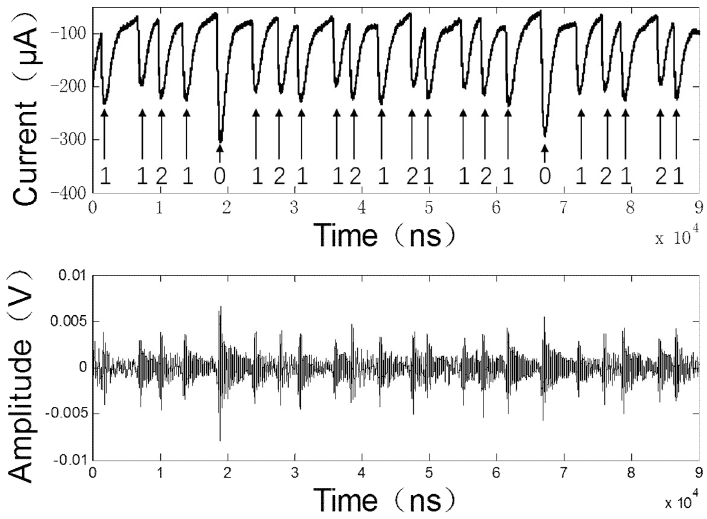
Figure 7. Trichel pulse current and radiation signal of the double-needle discharge structure.